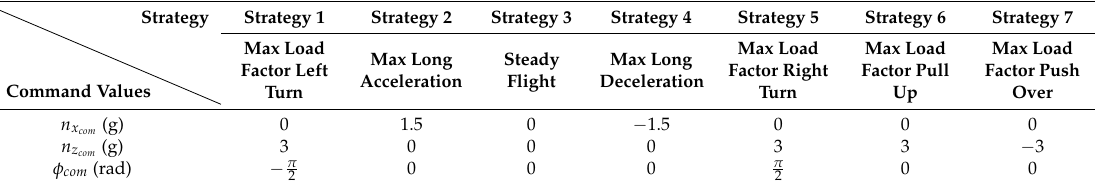
Table 1. Strategy and command value.